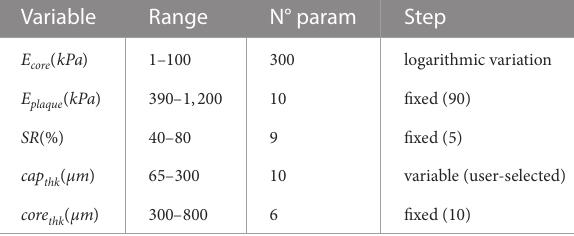
TABLE1 Proposedrangesforeachvariableofthemodelcomposingthe database.Mechanicalproperties( E core and E plaque )in kPa.Geometrical variables( SR , cap thk and core thk )in%and μm